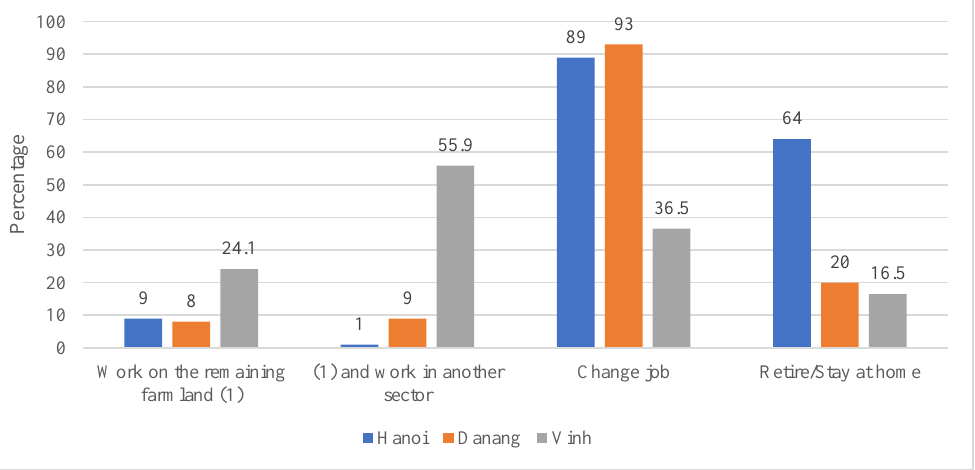
Figure 4. Employment changes after land acquisition. Source: Household survey, 2019 and 2020.